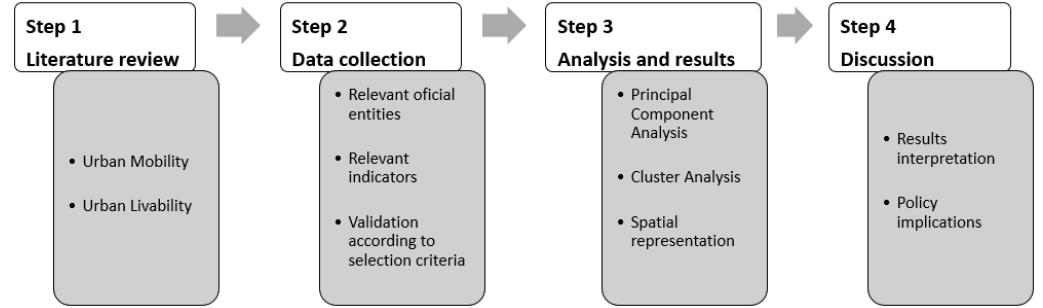
Figure 1. Methodological steps.